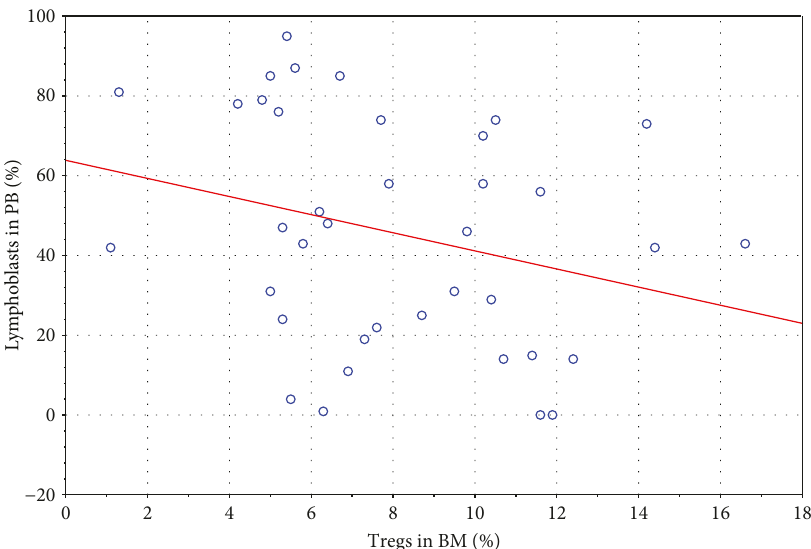
Figure 5: Correlation between the percentage of Tregs in BM and percentage of blasts in PB at the moment of diagnosis ( R = – 0 36 ).